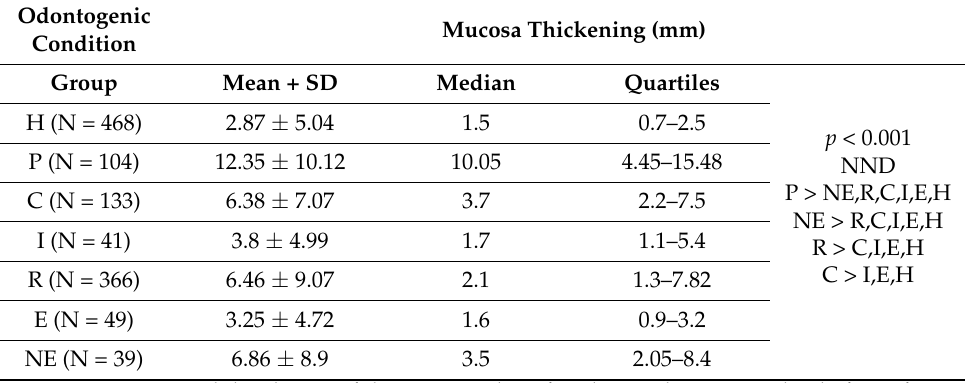
Table 2. Comparison analysis of mucosal thickening according to odontogenic condition.